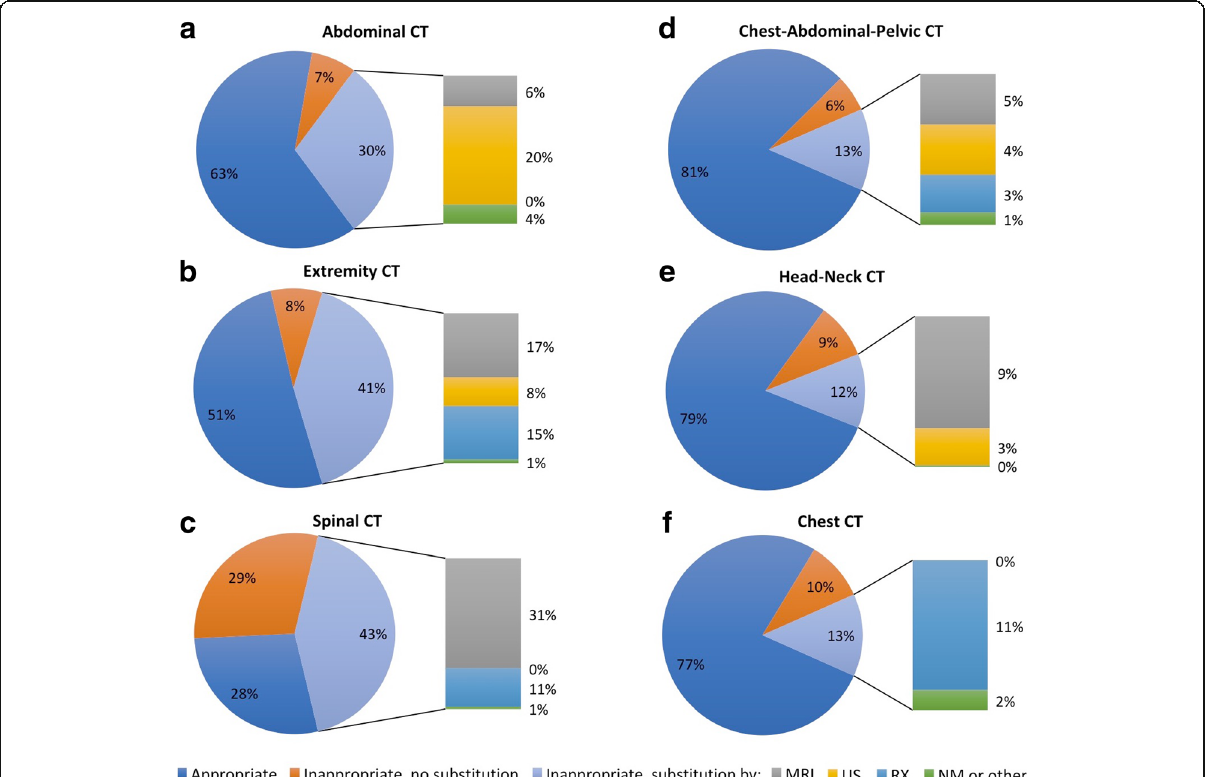
Fig. 5 Diagrams showing for CT for each anatomical area ( a abdomen; b extremities; c spine; d chest-abdomen-pelvis; e head-neck; f chest): the proportion of appropriate requests, the proportion of inappropriate requests for which no other examination was proposed instead and the proportion of different types of other examinations that were proposed. CT computed tomography, MRI magnetic resonance imaging, US